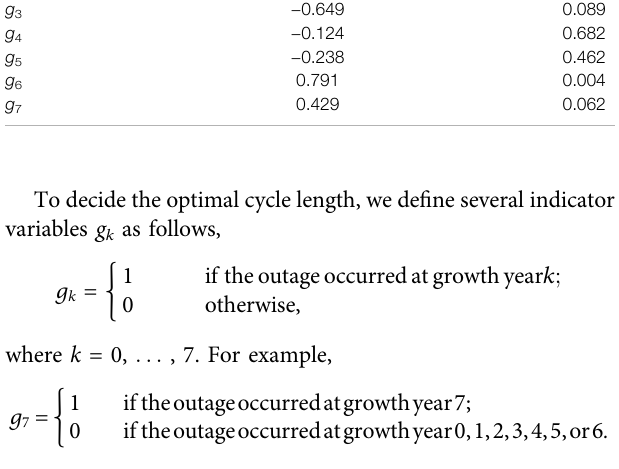
TABLE 4 | The fi xed effect estimates, p -values, values of AIC and BIC from the Poisson, NB, ZIP, and ZINB GLM models. Mixed model